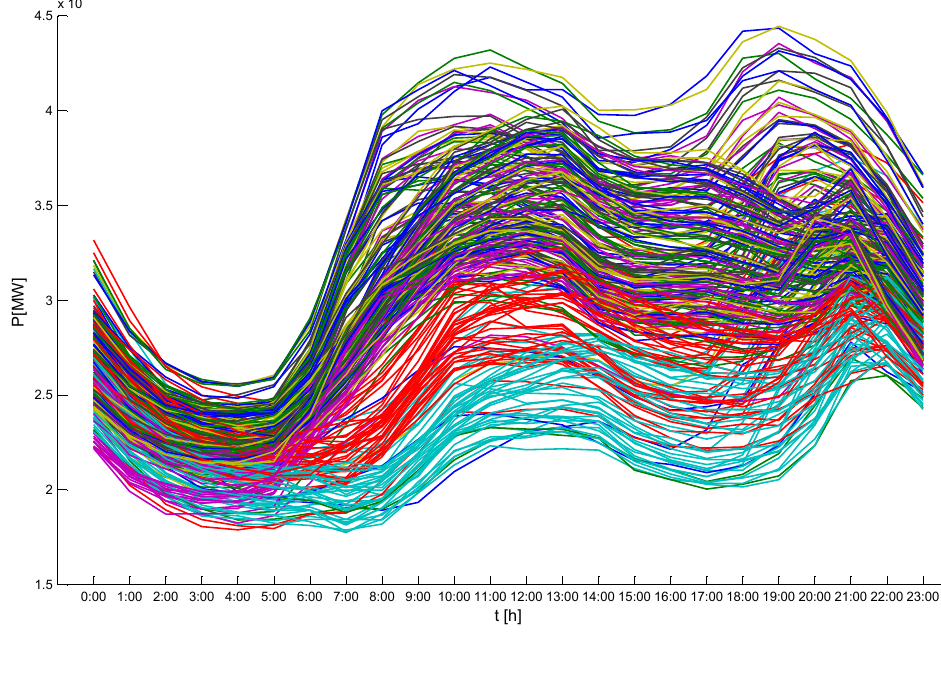
Figure 2. Daily load curves of Spain from January to